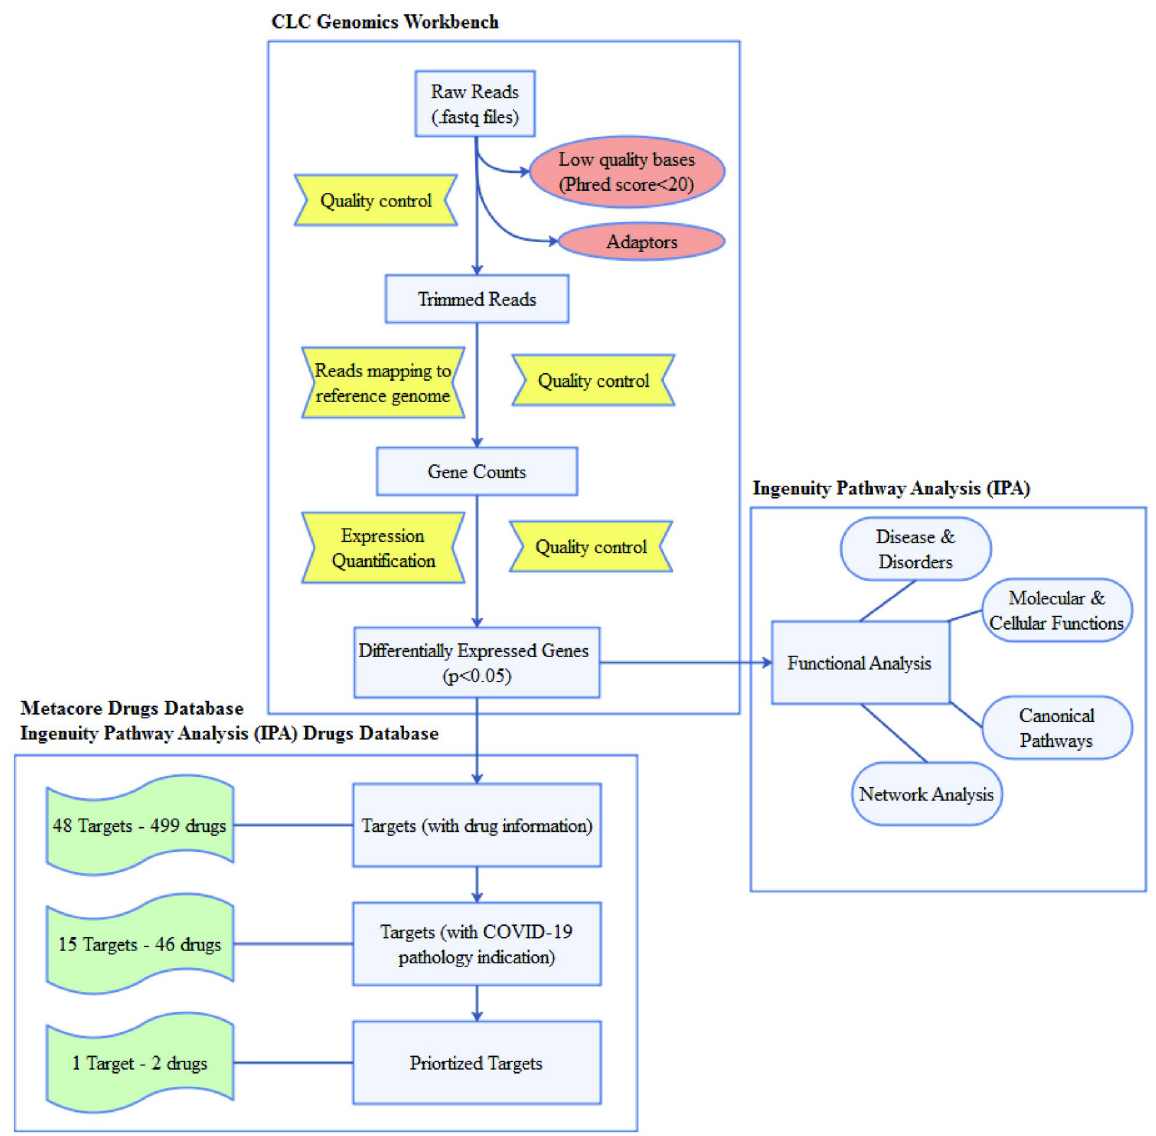
Fig 1. Flow-chart of the drug repositioning strategy for COVID-19 based on SARS-CoV-2 triggered gene expression signature in airway